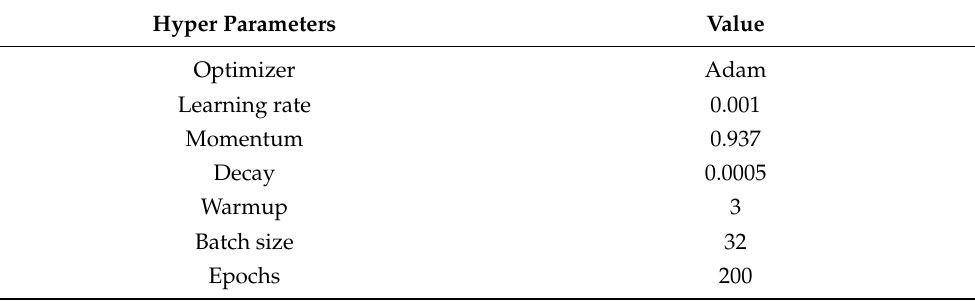
Table 1. Hyperparameter settings during model training.